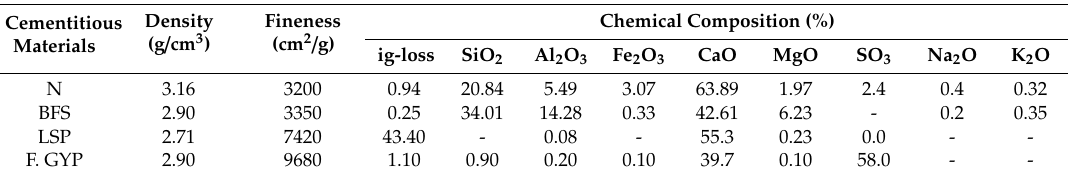
Table 1. Physical and chemical properties of binders used.